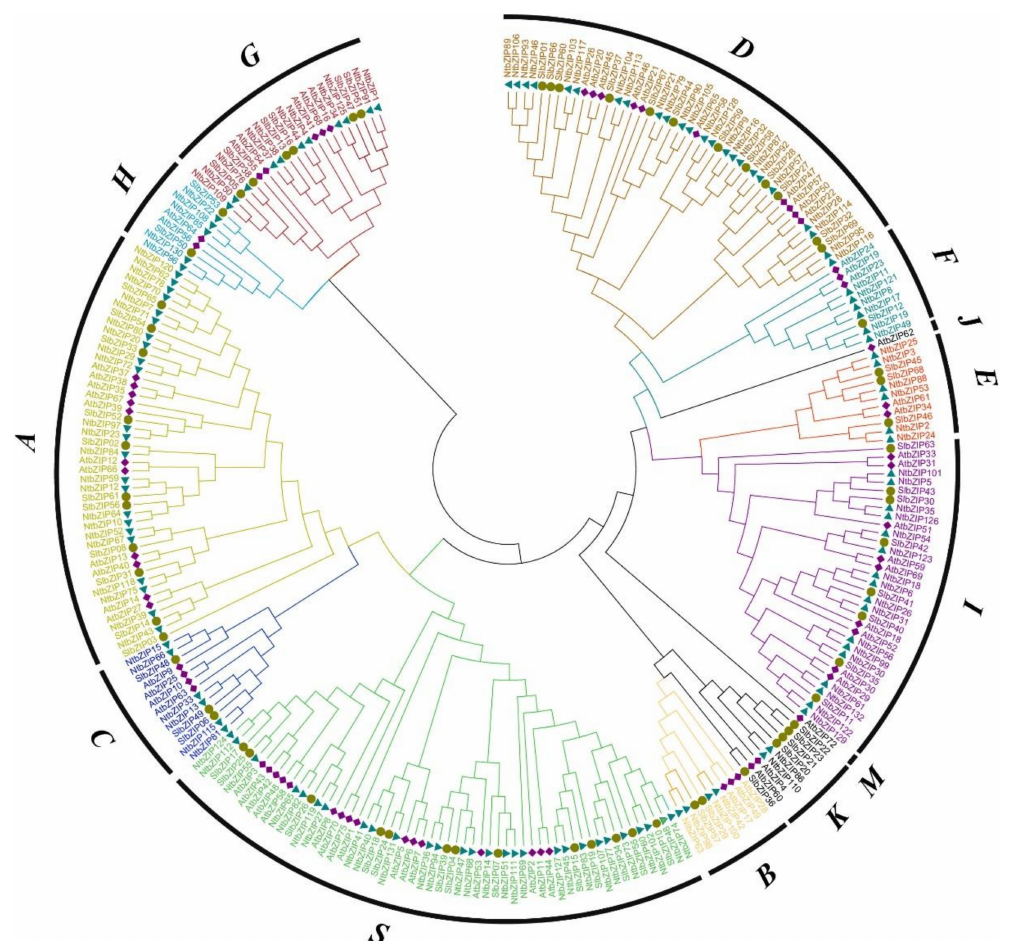
Figure 1. Phylogenetic analysis dendrogram of bZIP members in tobacco. The phylogenetic tree was constructed by bZIP proteins of tobacco, tomato and Arabidopsis with the Neighbor-Joining